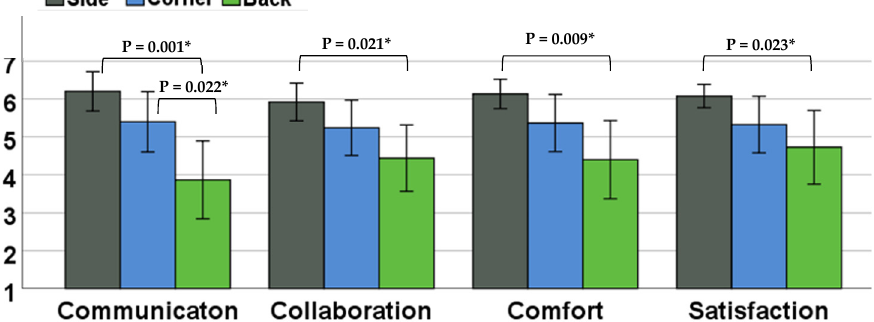
Figure 10. Mean ratings with significant results (*: statistically significant) on communication, collaboration, comfort, and satisfaction categories depending on three position arrangements for the Non-Shared group. Error bar indicates ± 2 standard